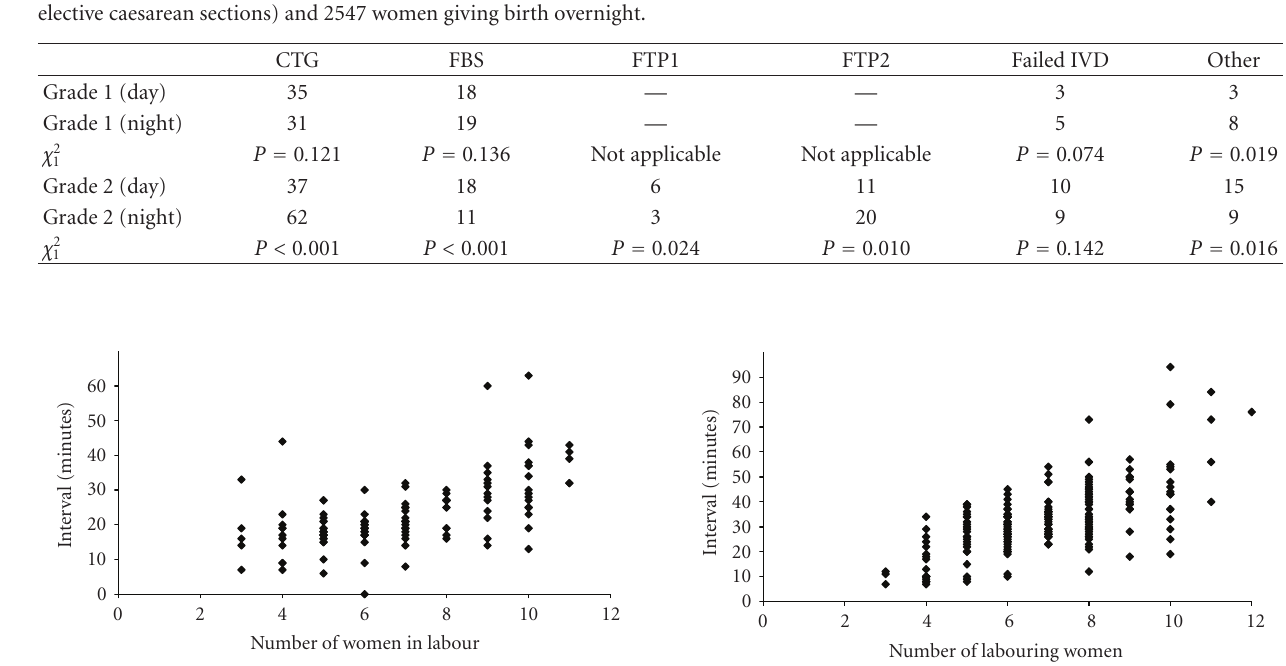
Figure 3: Decision-to-delivery interval versus number of labourers (grade 1).